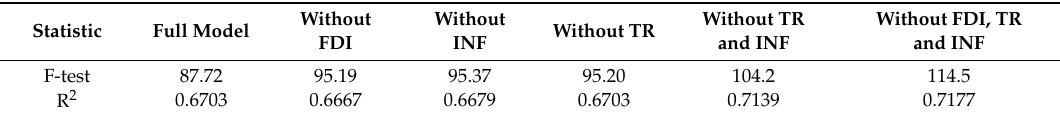
Table 5. Models with omitted variables.